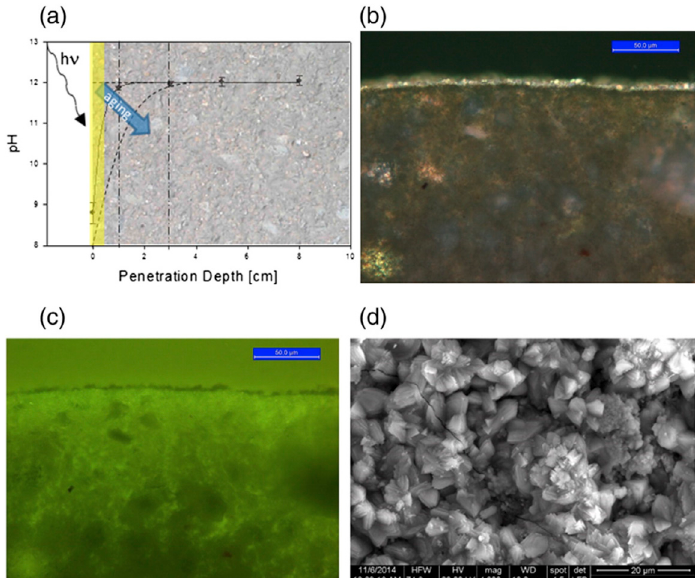
Figure 40. ( a ) Schematic illustration of pH changes and light penetration profile in the ageing concrete; ( b ) optical microscope image of the cross section of a concrete specimen containing TiO 2 under X-polarized light—note the surface exhibits a thin calcite layer that appears in a lighter colour; ( c ) optical microscope image of the cross section of a concrete specimen containing TiO 2 under fluorescent light—note that the calcite layer now appears dark green indicative of low porosity; and ( d ) SEM image of the top surface of a concrete specimen containing TiO 2 (same sample as in ( b , c )) wherein the surface consists of a layer of small, closely spaced, euhedral calcite crystals—no TiO 2 photocatalytic clusters are exposed. Reproduced with permission from Macphee and Folli [129]. Copyright 2016 by Elsevier Ltd. (License No.: